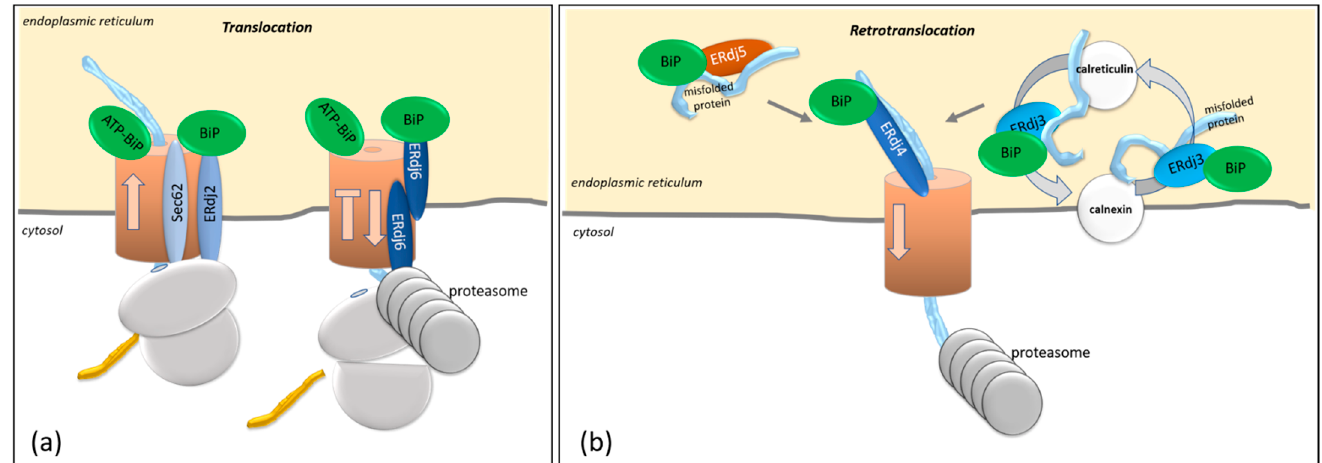
Figure 3. ( a ) Cotranslational translocation of proteins occurs via the Sec61 translocon and is mediated in a BiP-dependent way either in the absence or presence of ERdj2, depending on the respective target protein. Cotranslational degradation of a target proteins is controlled by ERdj6. The retrotranslocation of targets that clog the translocon is BiP-dependent. ( b ) The degradation of luminal target proteins is mediated by ERdj3, ERdj4, and ERdj5. ERdj3 seems to compete with target proteins for the binding of calnexin or calreticulin and controls the degradation or folding of proteins. ERdj4 also mediates either the folding of proteins or, in the case of enduring misfolding, targets the protein to the ERAD pathway. The specific feature of ERdj5 is its reductive ability, required to release disulifide bonds in order to enable a subsequent retrotranslocation across the ER membrane.